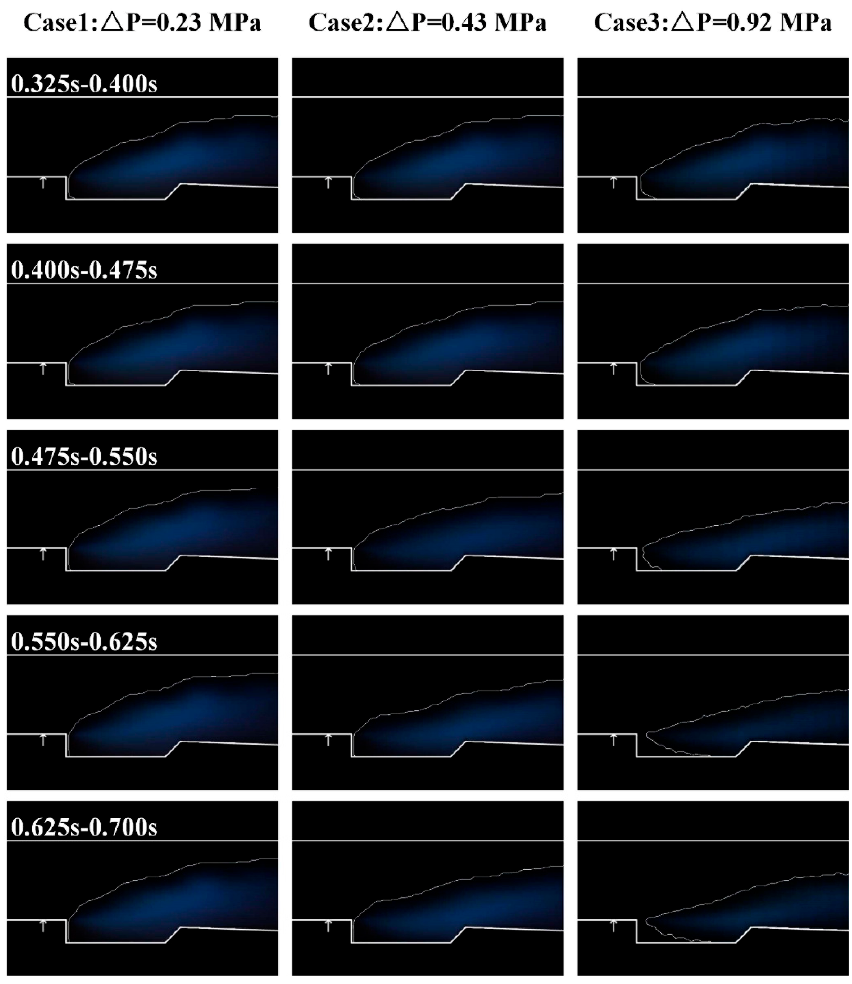
Figure 10. Time-averaged flame within different time periods.